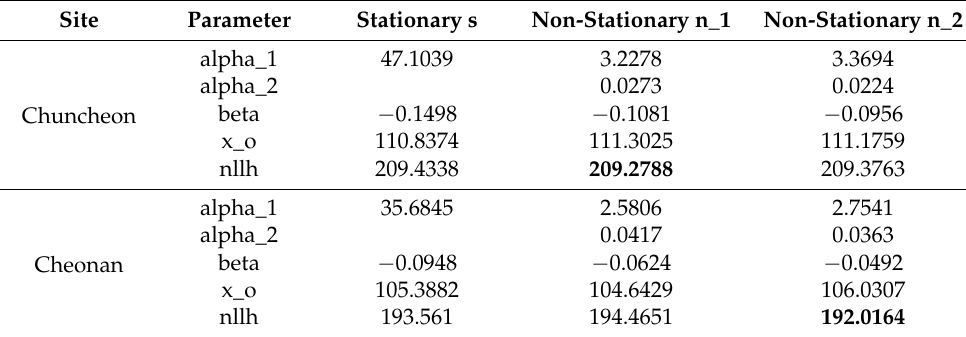
Table 2. Parameters and negative log